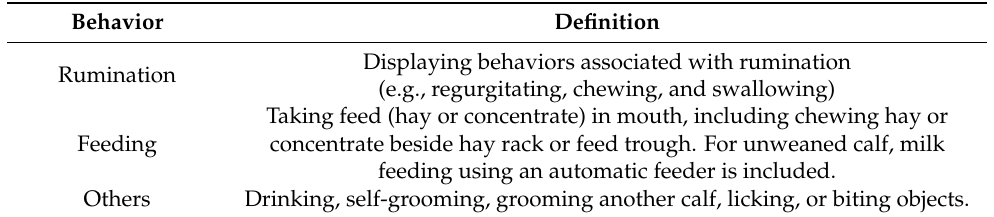
Table 3. Definitions for the behaviors observed during the study investigating the suitability of wearable cameras for monitoring juvenile bovine